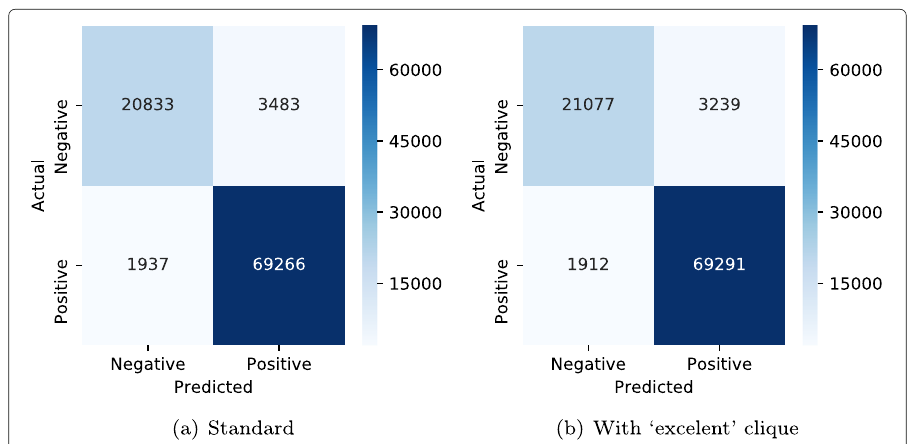
Fig. 4 Confusion matrices for ( a ) standard classification and ( b ) classification when words included in a maximum clique around word ‘excelent’ from the respective word embedding are treated as words with the same meaning. Accuracy scores of a classifier on a training and test instances are equal to ( a ) 0.9483, 0.9433 and ( b ) 0.9521, 0.9461